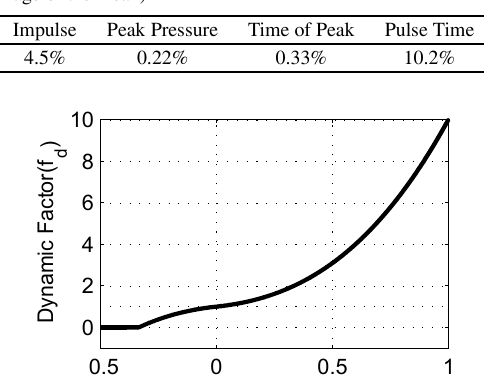
Table 1 Maximum deviation from the mean of each response pa-